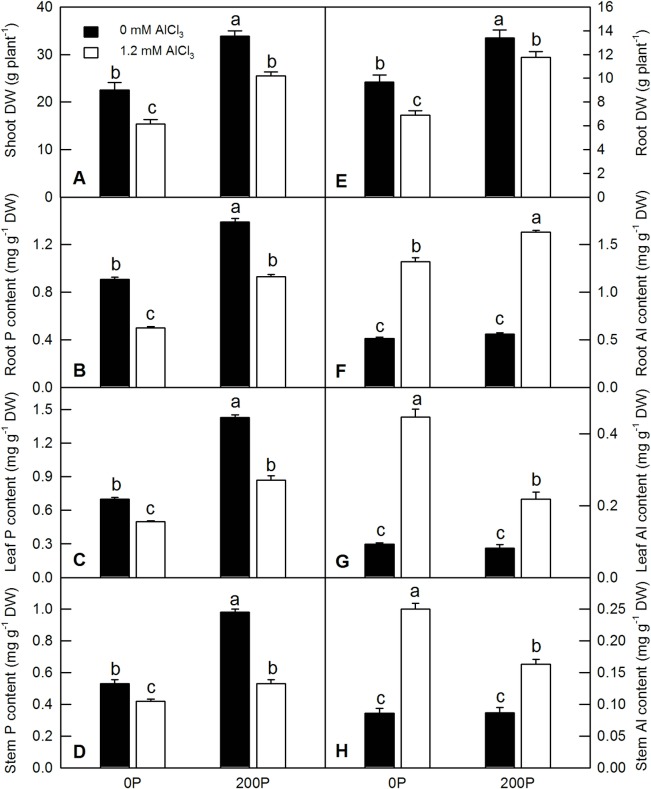
Effects of P-Al interaction on plant dry weight (DW; shoot, A; root, E), P content (root, B; leaf, C; stem, D) and Al content (root, F; leaf, G; stem, H) in C. grandis seedlings. Bars represent means ± SE (n = 5 for P and Al contents or 10 for plant DW). Differences among the four treatment combinations were analyzed by 2 (B levels) × 2 (Al levels) ANOVA. Different letters indicate a significant difference at p < 0.05.